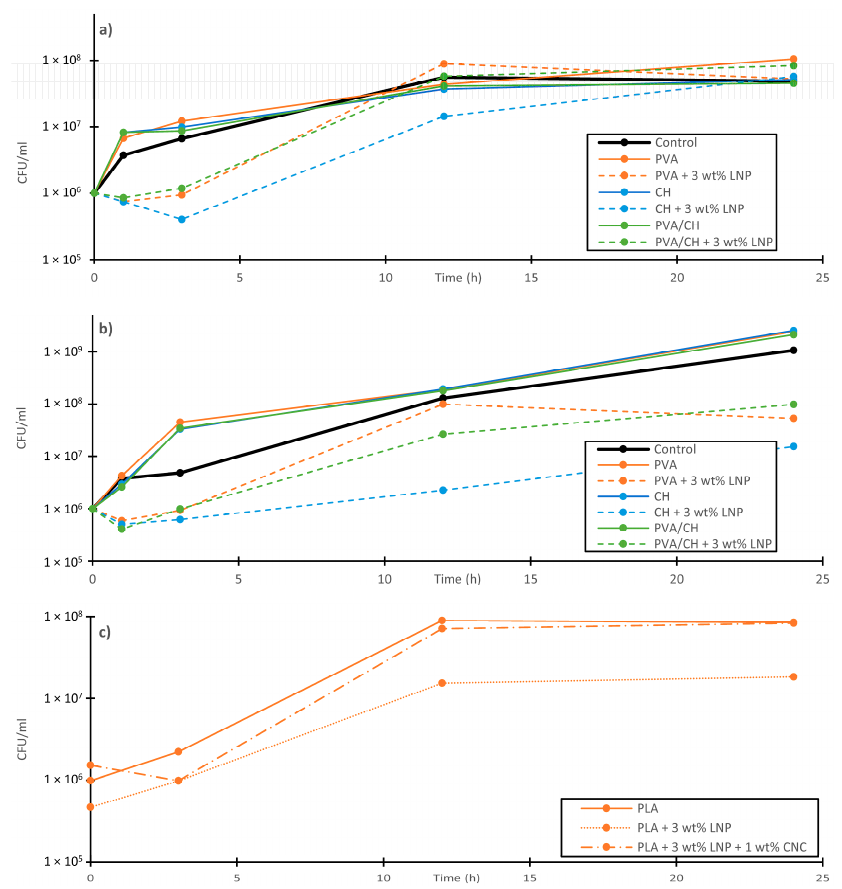
Figure 3. Results of the antimicrobial liquid medium test of polylactic acid (PLA), polyvinyl alcohol (PVA) and chitosan (CH) polymer blends against different bacteria; ( a ) Pectobacterium carotovorum subsp. odoriferum (CFBP 1115); ( b ) Xanthomonas arboricola pv. pruni (CFBP 3894); ( c ) Pseudomonas syringae pv. tomato (CFBP 1323). Adapted from Yang et al. [17,32], with permission from Elsevier.